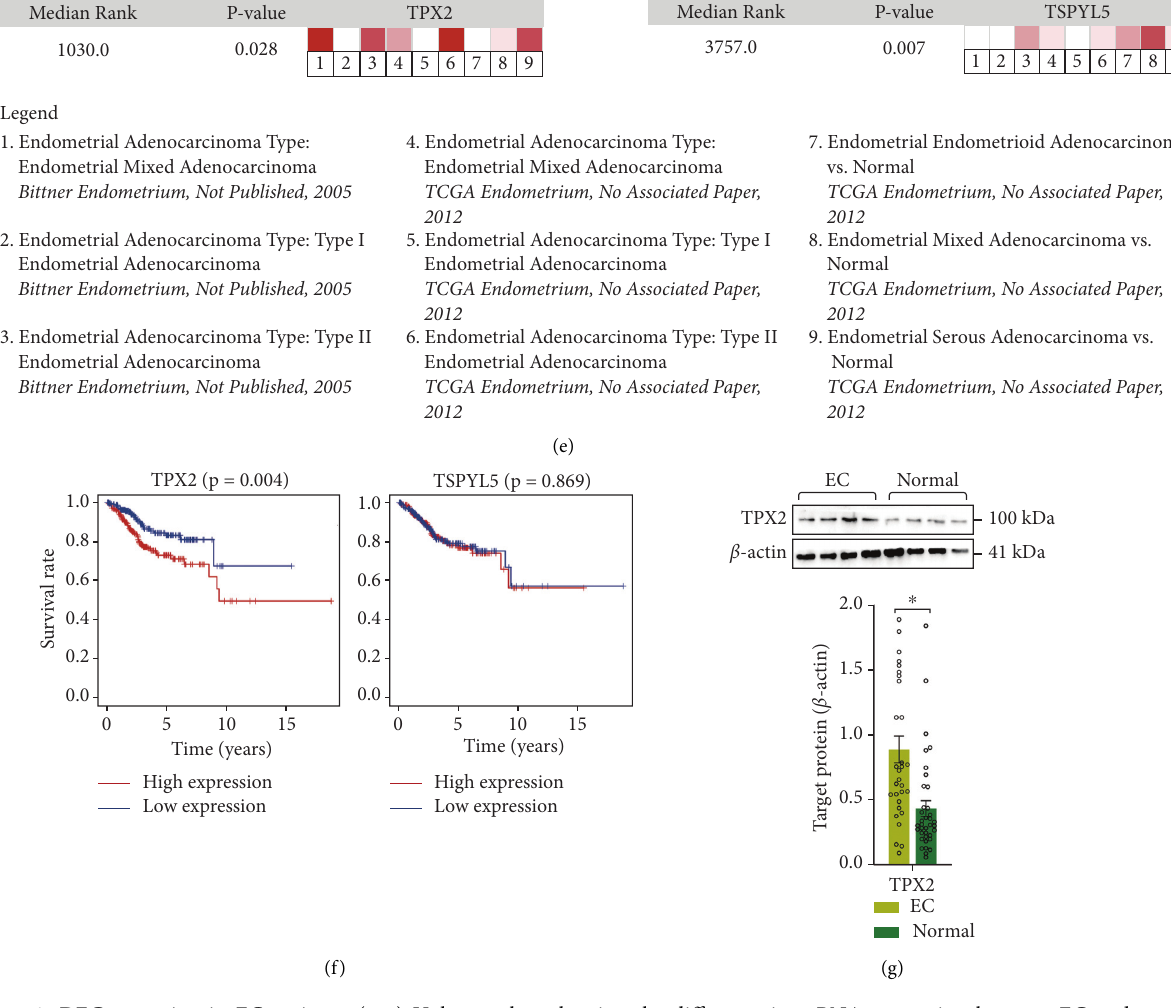
Figure 2: DEG screening in EC patients. (a–c) Volcano plots showing the difference in mRNA expression between EC and normal endometrial tissues. (d) Venn diagram showing overlap among candidate mRNAs with a |log2 (fold -change)| of > 2.0 in EC tissue compared with those in normal endometrial tissue. (e) The mRNA level of each candidate DEG was validated with the oncomine microarray database. (f) Comparison of the survival curves between low- and high-expression groups based on the median expression value of candidate differentially expressed genes. (g) Immunoblot showing the prognostic signature associated with TPX2 protein and quantitative data. ∗ p < 0 . 05 vs. normal group. EC: endometrial cancer; FC: fold change; FDR: false discovery